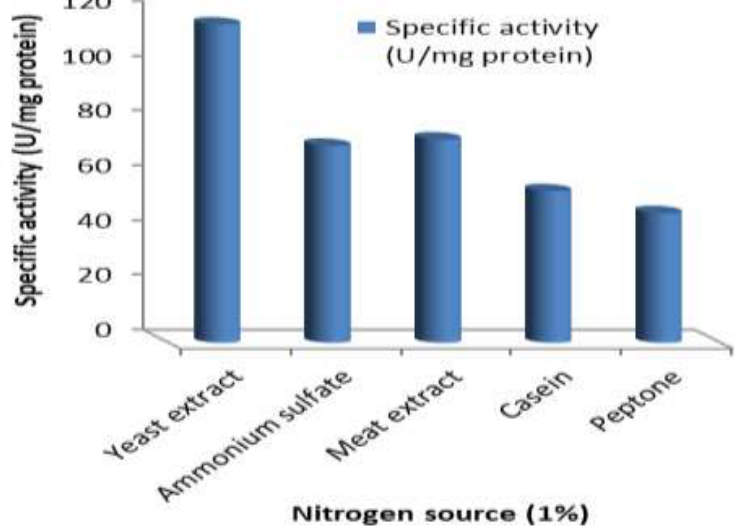
Figure 2: The optimum nitrogen source for